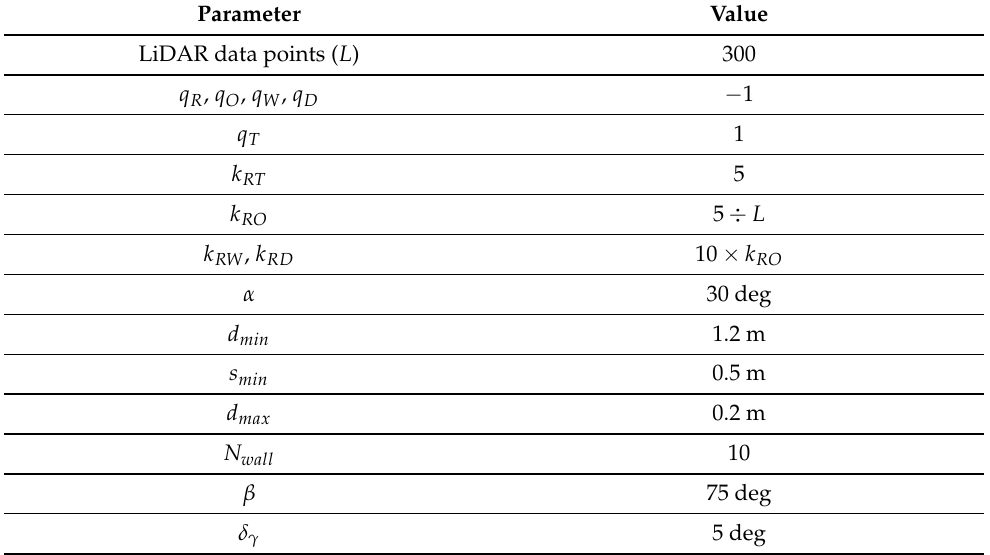
Table 1. The parameters of the proposed AR-APF.